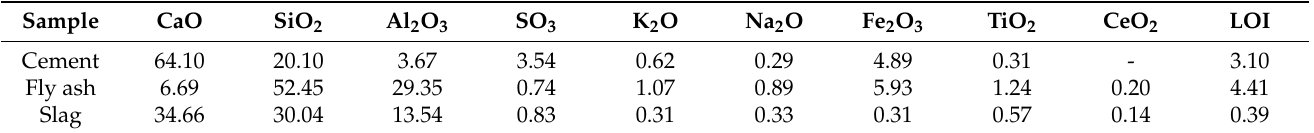
Table 1. Chemical composition of cement, fly ash, and slag (%).